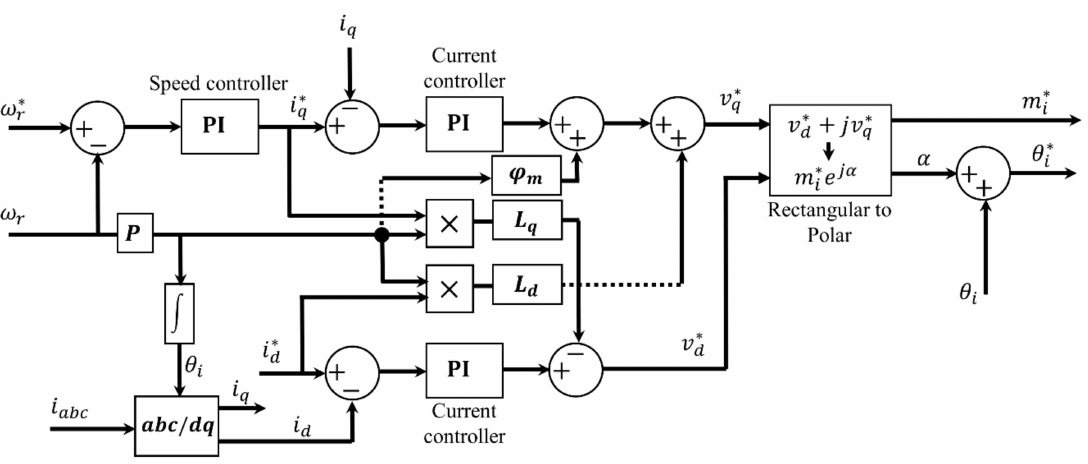
Figure 7. Speed control of PMSM drive side